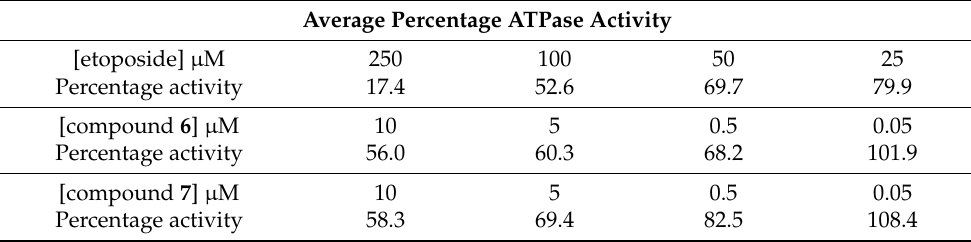
Table 2. The percent of average ATPase activity obtained from two runs for the investigated com- pounds 6 and 7 , and for etoposide at 4